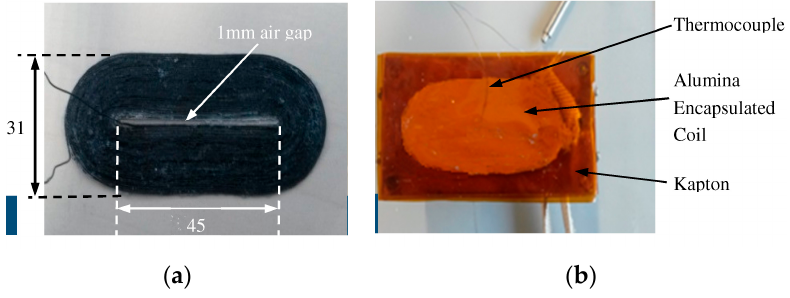
Figure 8. ( a ) Constantan Coil; ( b ) Alumina and Kapton encapsulated coil (in mm).